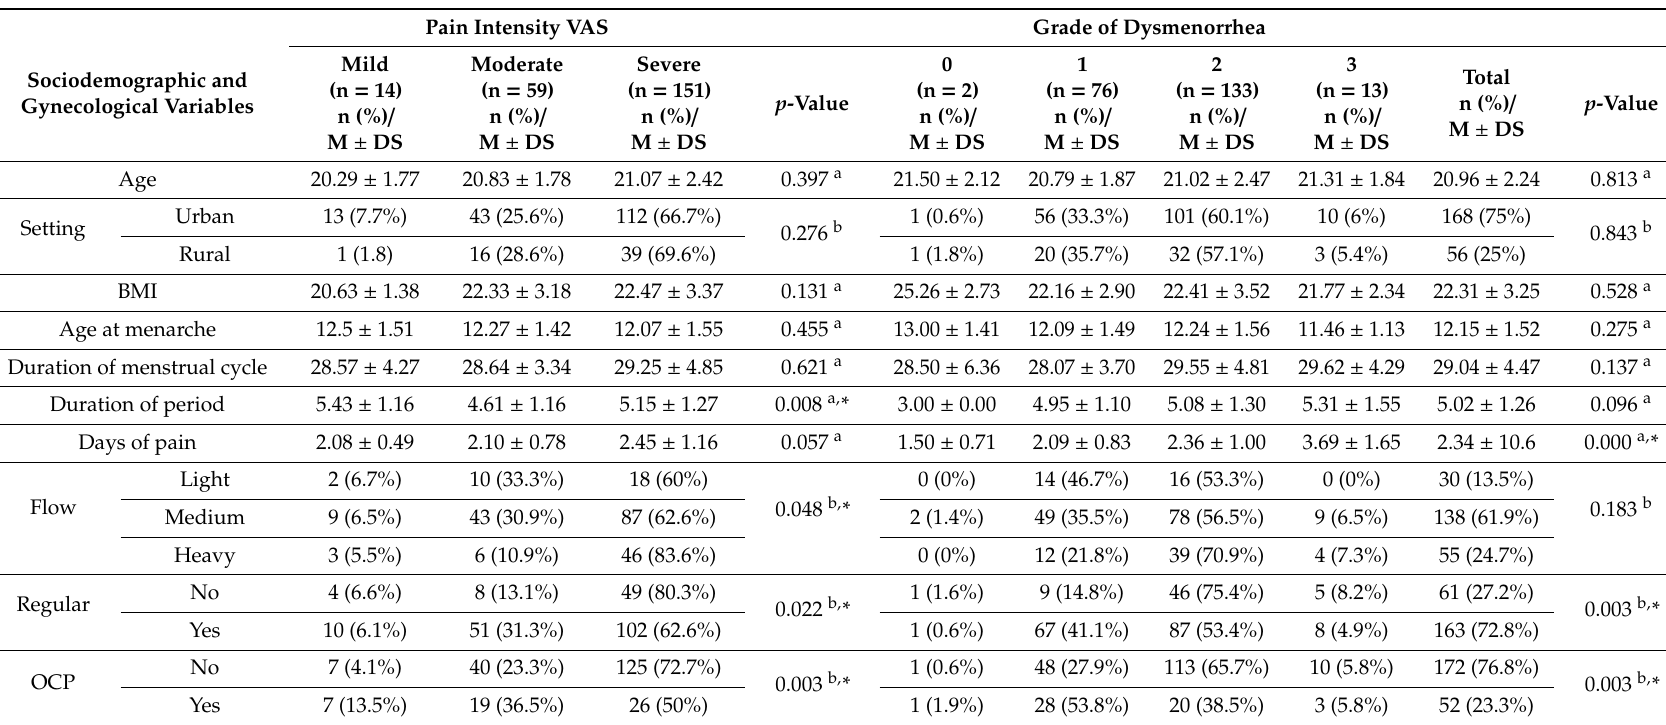
Table 1. Comparison of sociodemographic and gynecological factors between women with di ff erent levels of menstrual pain and grades of dysmenorrhea.